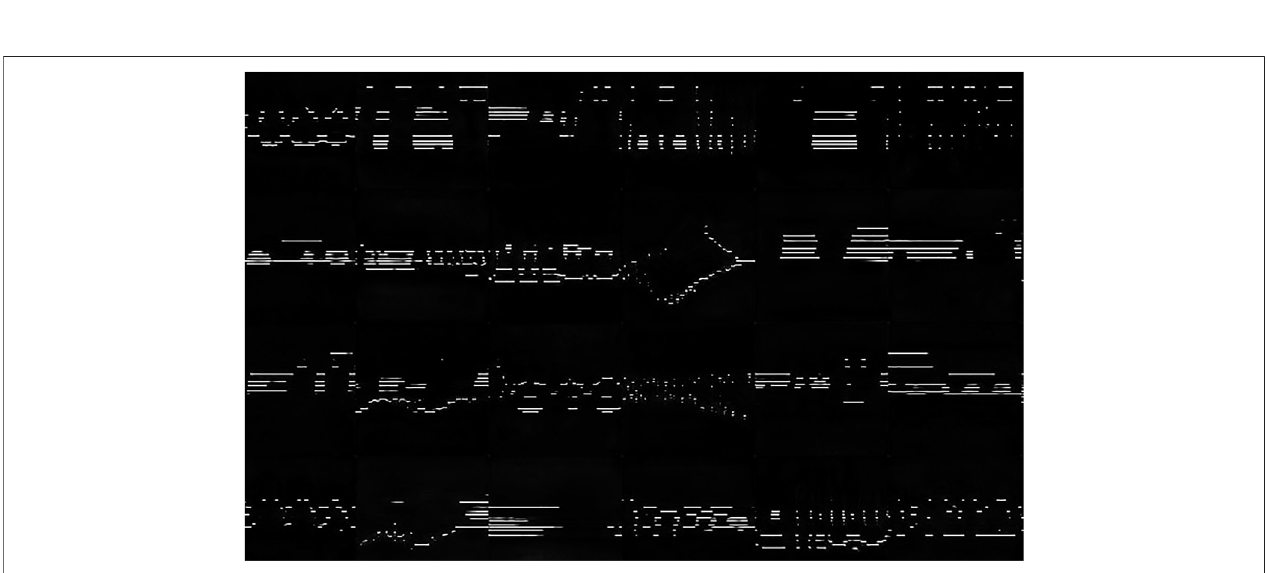
FIGURE 9| 24 examplesof fake piano rolls generated by StyleGAN Pianorolls arranged in 4rows and 6columns. The generated excerpts exhibit greatvariation in their musical structure, as it is the case of the input data.